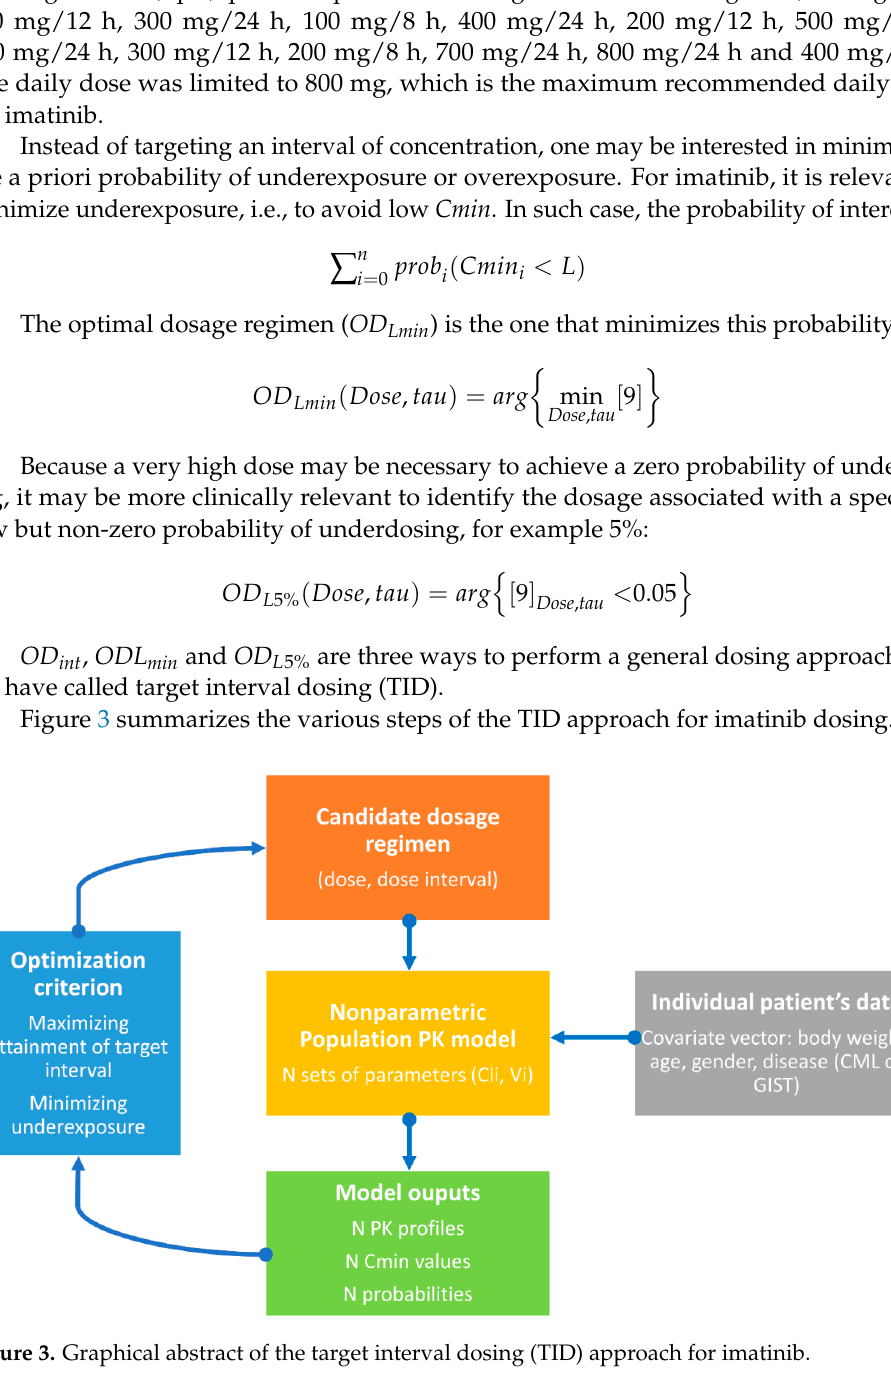
Figure 3. Graphical abstract of the target interval dosing (TID) approach for imatinib.